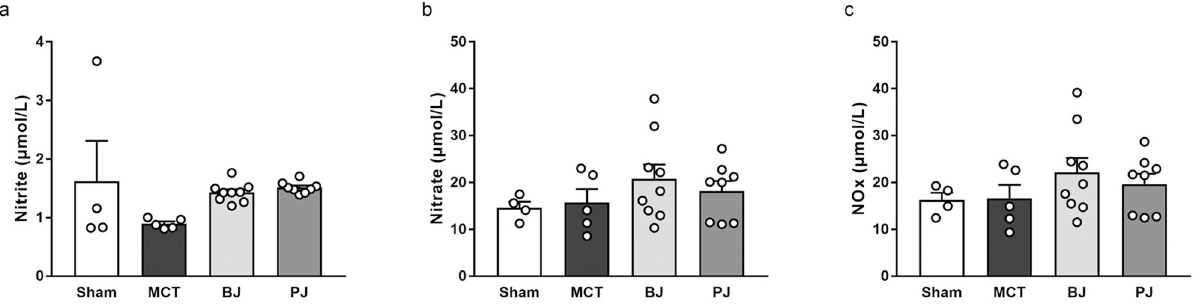
Fig 4. Effects of nitrate-depleted BJ supplementation on plasma NO levels in MCT-injected rats. (a) nitrite. (b) nitrate. (c) NOx. Each point represents individual value; each column and bar represent the mean ± SEM values of 4–9 experiments. Statistical analysis was performed using one- way analysis of variance with Sidak post hoc test. Abbreviations: BJ, beetroot juice; PJ, placebo juice; MCT, monocrotaline; NOx, nitrite plus nitrate.